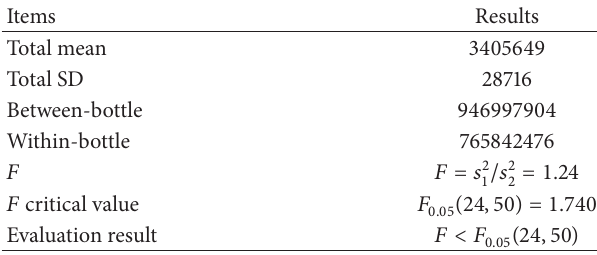
Table 2: Mass fraction of chloramphenicol measured by MB methods.